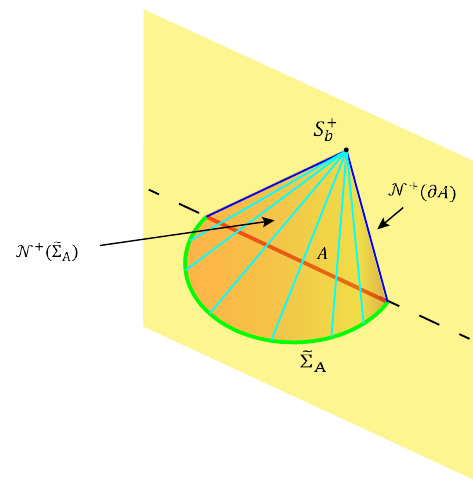
Figure 5 . We are only showing the future components. In the absence of the bulk caustics on it, (cid:0) ˜Σ (cid:1) intersects with the asymptotic boundary at N + A a null-cone tip in our